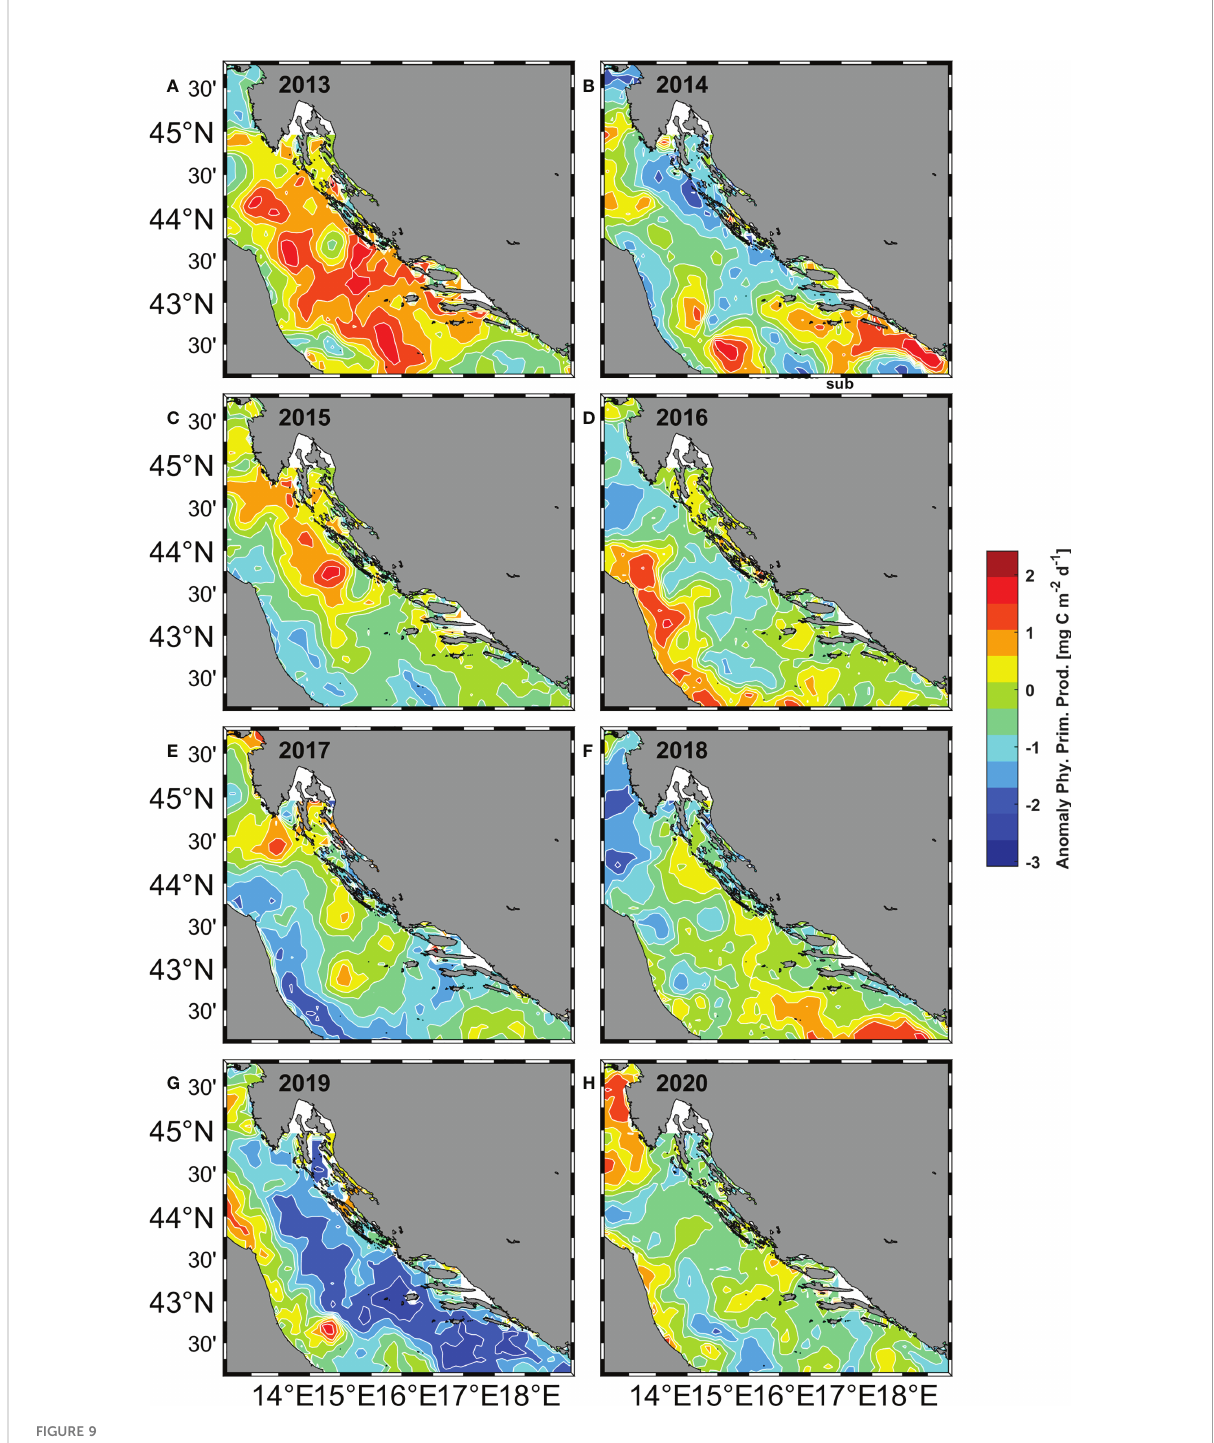
FIGURE 9 Spatial distribution of phytoplankton primary production anomalies in the Adriatic Sea for the month of July in the period 2013 - 2020 (A – H)